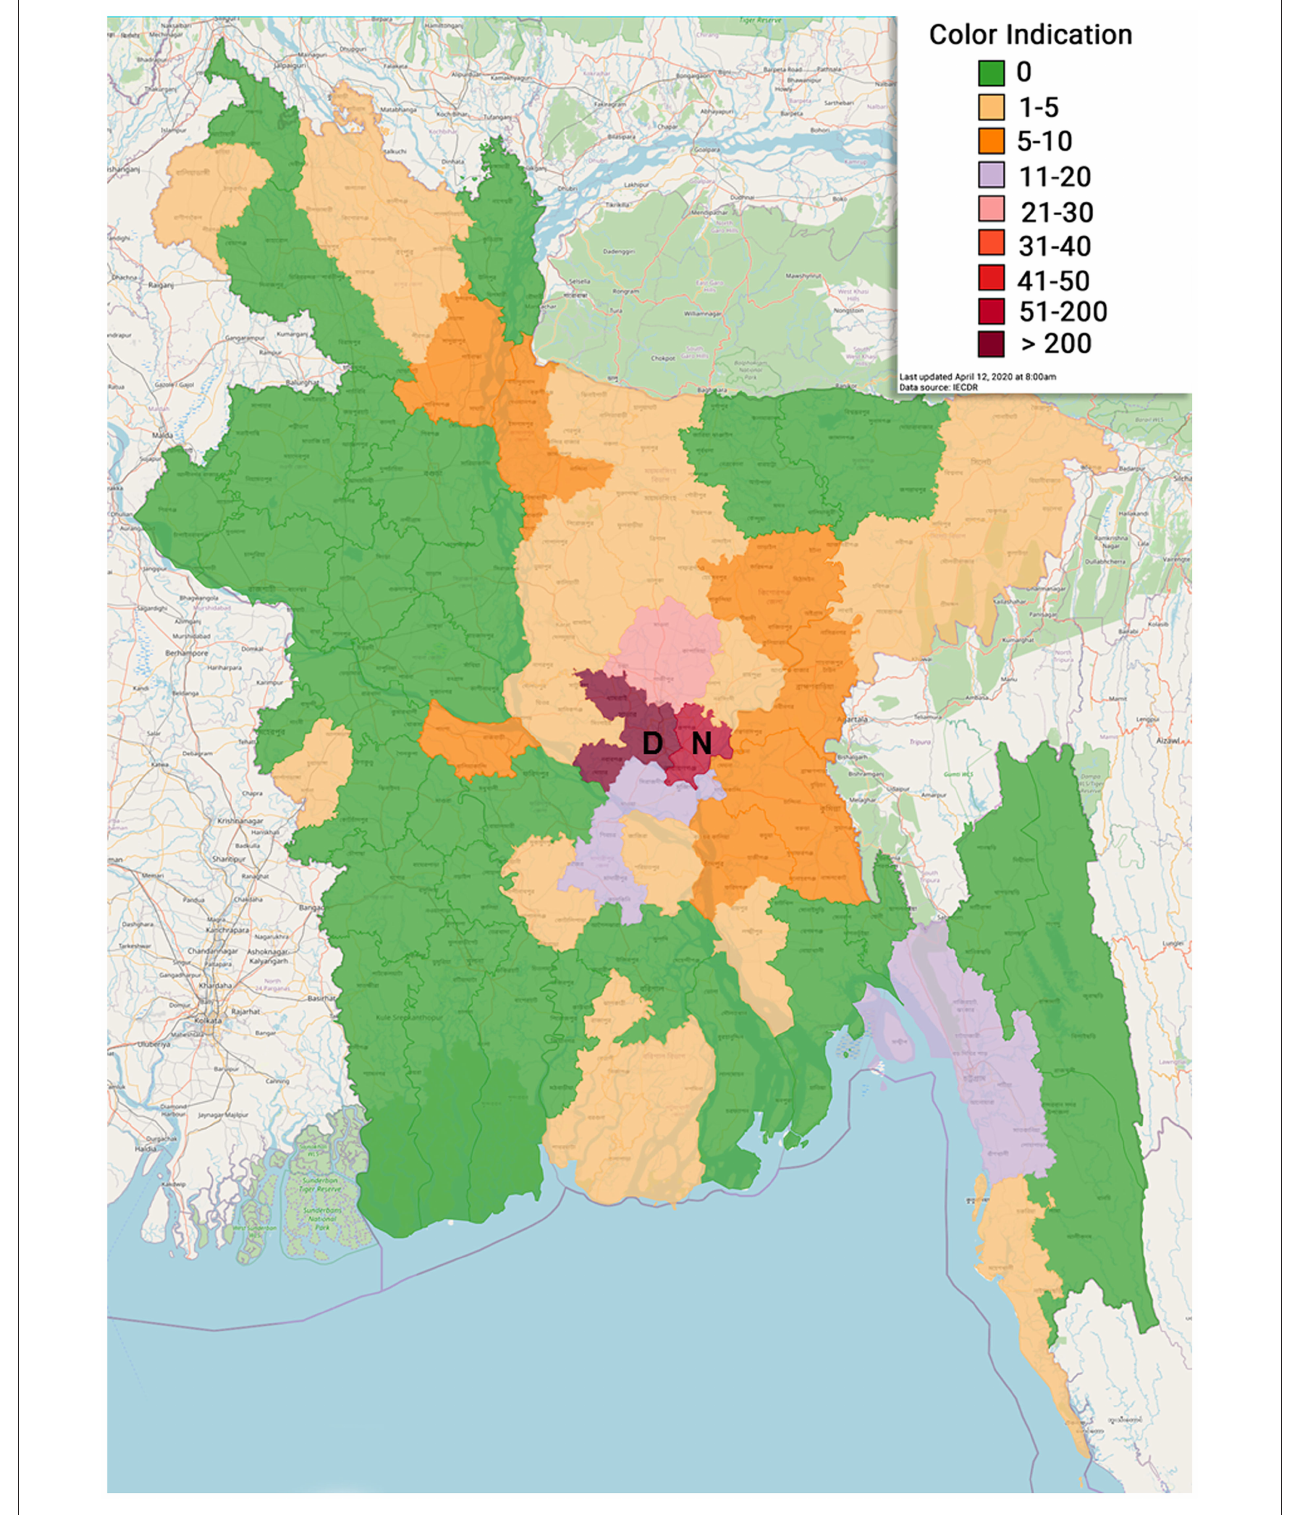
FIGURE 5 | Geographical distribution of COVID-19 positive cases in various administrative districts of Bangladesh (D, Dhaka; N, Narayangonj).